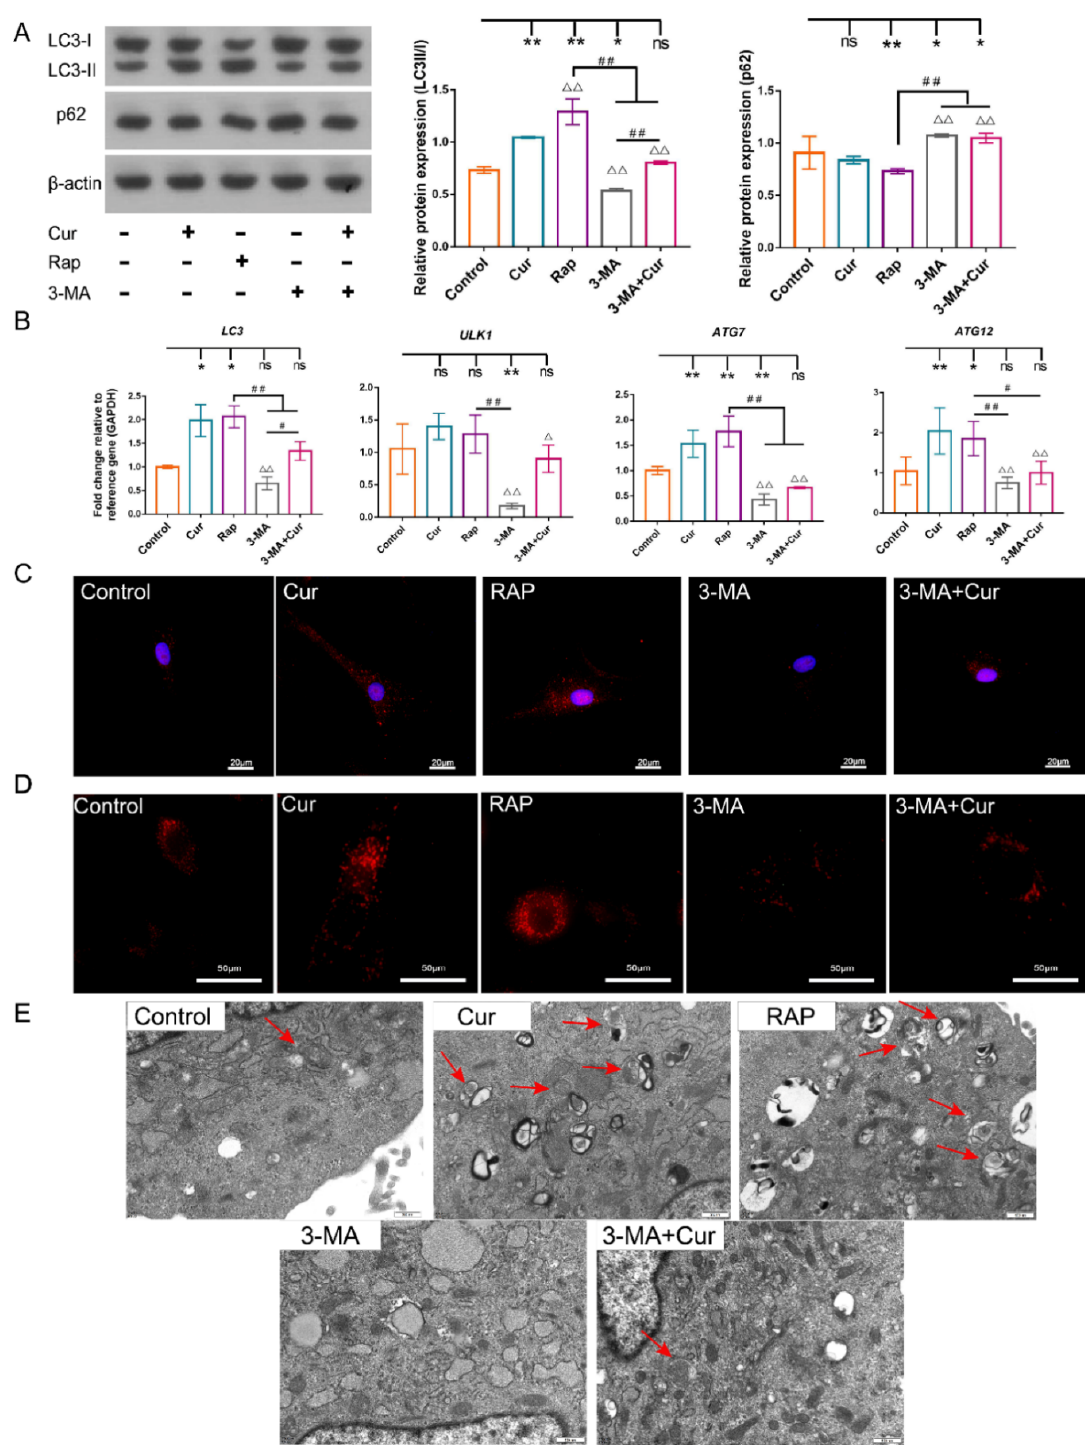
Figure 5. The effects of modulated autophagy through the employment of RAP (100 nM) and 3-MA (5 mM) in cBMSCs (P6). ( A ) Immunoblots showing the protein expression levels of p62, LC3-I, and LC3-II in cBMSCs, β -actin was used as the loading control. ( B ) The relative expressions of LC3 , ATG12 , ATG7 , and ULK1 in cBMSCs were analyzed using RT-qPCR. ( C ) cBMSCs were treated or untreated with Cur (0.1, 1, and 10 μ M) and then stained with LysoTracker Red DND-99 (60 nM); scale bars = 50 μ m. ( D ) Representative immunofluorescence images showing LC3 punctae (red) in cBMSCs; scale bars = 50 μ m. ( E ) The ultrastructure of cBMSCs was examined with transmission electron microscopy. The red arrows show autophagosomes and autolysosomes; scale bars = 500 nm. * p < 0.05, ** p < 0.01 compared with the control group; Δ p < 0.05, ΔΔ p < 0.01 compared with the Cur group; # p < 0.05, ## p < 0.01 for intragroup comparisons.